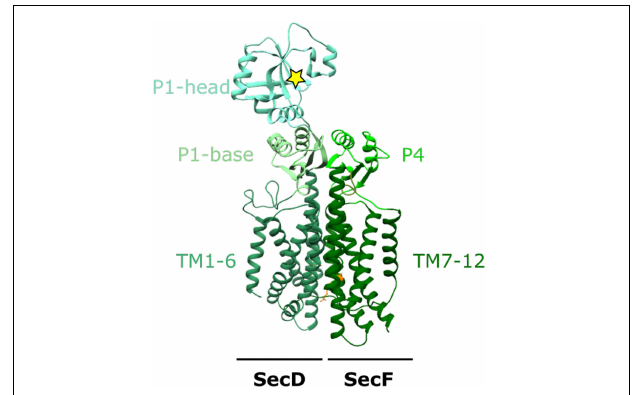
FIGURE 1 | The structure of SecDF. X-ray crystal structure of SecDF in I- form conformation from Deinococcus radiodurans R1 PDB:5XANb (Furukawa et al., 2017). TM1-6 from SecD and TM7-12 from SecF make up the 12 TM helices characteristic of the RND superfamily. The periplasmic domains: P1-base and -head in SecD and P4 in SecF, interact to form a domain which moves in response to proton influx through a proton wire (including SecD D 519 and SecF R 247 ; orange) within the membrane domain. The yellow star depicts a hydrophobic pocket within the P1-head of